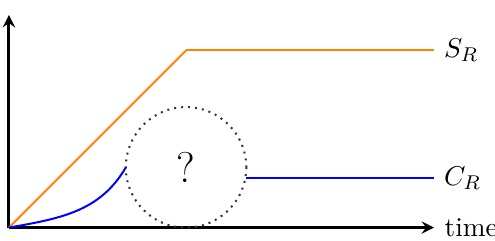
Figure 1 . A typical shape of the entanglement entropy (orange) and an asymptotic form of the capacity of entanglement (blue) at early and late times for black holes with the Hawking radiation. The entropy grows linearly and saturates after the Page time while the capacity is vanishing at early time and approaches some value at late